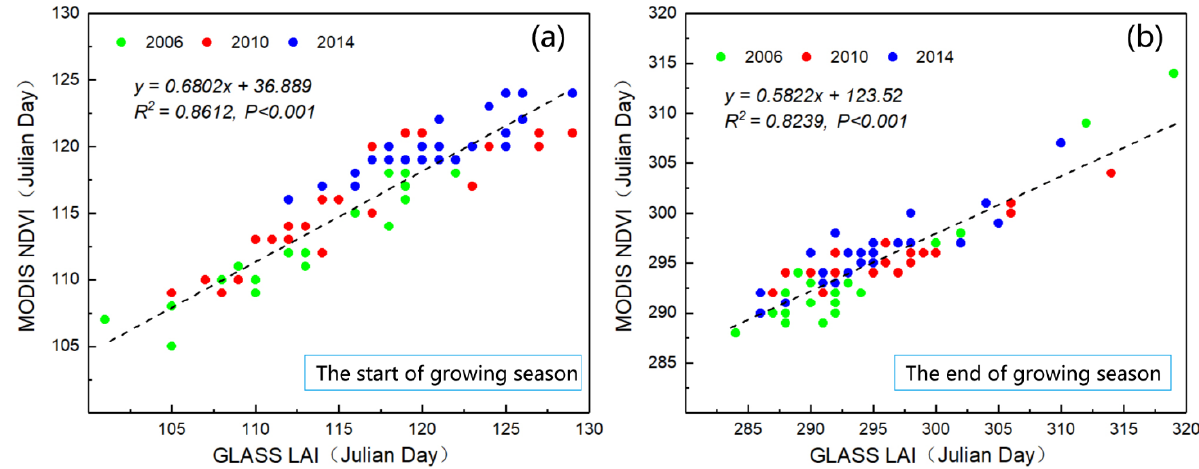
Figure 8. Extraction of P. euphratica phenology based on MODIS NDVI and GLASS LAI data. ( a ) Start of the growing season (SOS), ( b ) end of the growing season